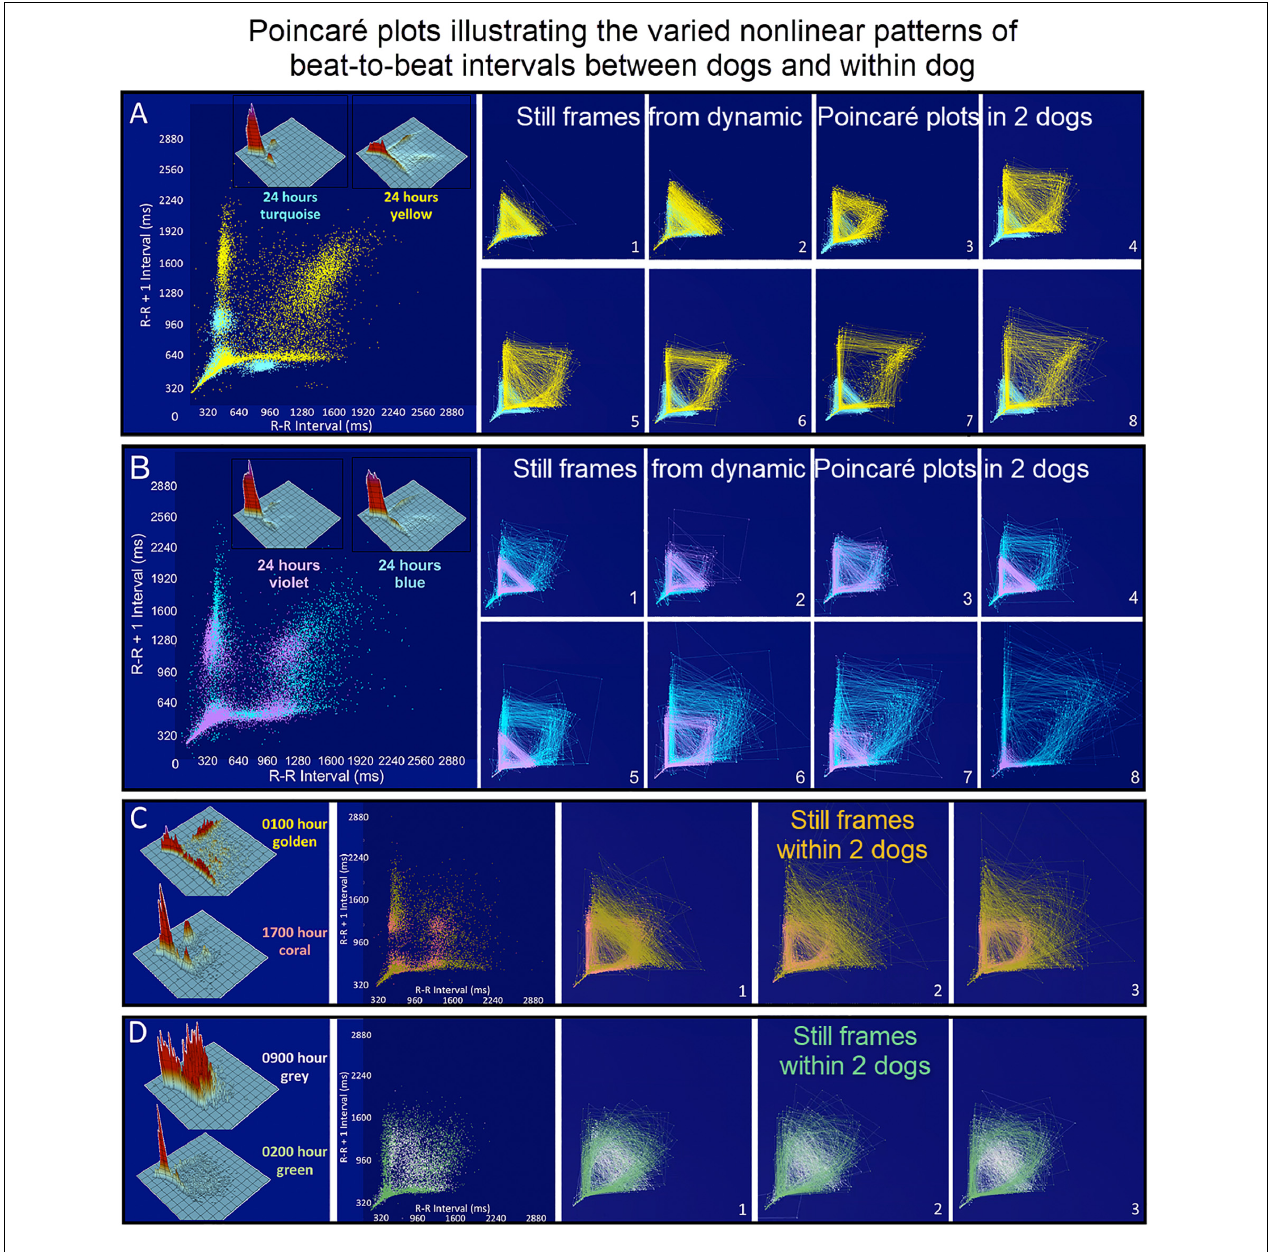
FIGURE 7 | ( Supplementary Videos 3–6 ) Still frames from dynamic Poincaré plots (http://wyattflanders.com/poincareplot/) of six different dogs demonstrate the varied R–R interval patterns between dogs (frames A,B ) and within dogs (frames C,D ). In frames (A,B) large Poincaré plots without connecting lines contain 10,000 beat intervals and above this plot, the corresponding three-dimensional histographic Poincaré plots of the entire 24-h are shown. Below the three-dimensional histographic plots, a color code is stated for that dog that corresponds with the animated Poincaré plot in this figure and in the accompanying Supplementary Videos . To the right of this panel, from the dynamic two-dimensional Poincaré plots still frames of 1000 intervals with lines, the beat-to-beat relationships are presented. The still frames were captured at different time points during 24-h electrocardiographic recordings (Frames 1–8 ). In frame (A) , the dog in aqua (boxer) has a clustered pattern with no long–long intervals while the dog in yellow (small mixed-breed) has a long-branched pattern with a long–long R–R interval cloud. Compare the beat density of the dog in yellow (Frame A ) to the dog in blue (Frame B ). In frame (B) a boxer with a clustered pattern (color violet) also has the central cloud of long–long intervals. The Doberman pinscher in blue shows a large variation in long–long intervals. Frames (C,D) illustrate the varied patterns within dog. The hour of the day and color representing that hour for the dynamic Poincaré plots are indicated to the right of the three-dimensional histographic Poincaré plot for each dog. The pattern of sinus arrhythmia can change over time with varying autonomic input. This also shows that if the entire 24 h is considered at one time the true dynamics of the interval relationships can be masked. The dog in frame (C) (boxer) during the sleep hour 0100 (golden) has a ‘branched’ pattern with slower rates; however, a more clustered pattern with faster rate is identified during an hour of wakefulness (coral). The dog in frame (C) (Wheaton Terrier) during the 0900 h (gray) was noted to have wide swings in heart rate associated with different activities as documented in the diary. This resulted in many transitions of rate with a more dense pattern; however, during the sleep hour (green) a different pattern was identified with the zone of avoidance evident. Supplementary Videos 3–6 provided with this figure.